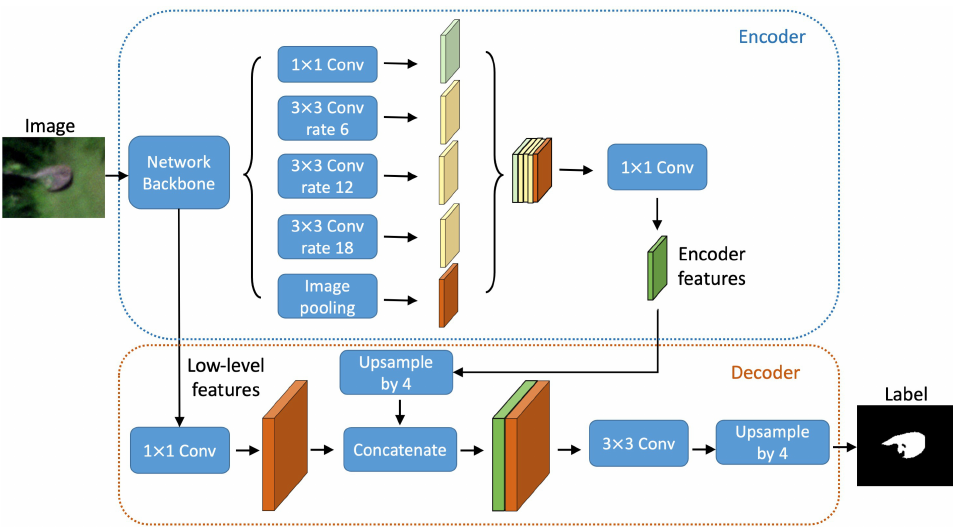
Figure 3. The architecture of Deeplabv3+ (modified from